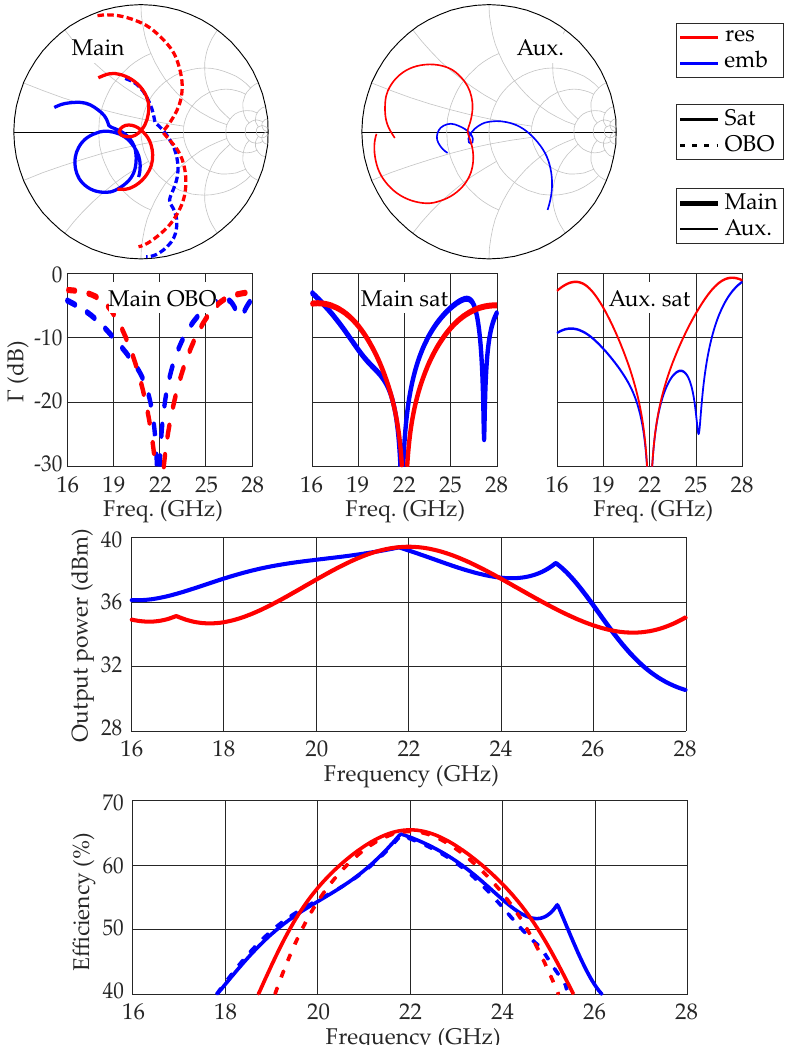
Figure 9. Effect of the parasitic output capacitance C out on the simulated frequency response, at saturation (solid) and at 6 dB back-off (dashed), of a combined DPA in GaN: resonated (red) and embedded into the combiner (blue). From top to bottom: synthesized loads at the current generator planes, saturated output power, efficiency. Table 6. Impact of the parasitic output capacitance of the transistors on the 25% bandwidth of a combined DPA in GaN, estimated by the simplified analysis.